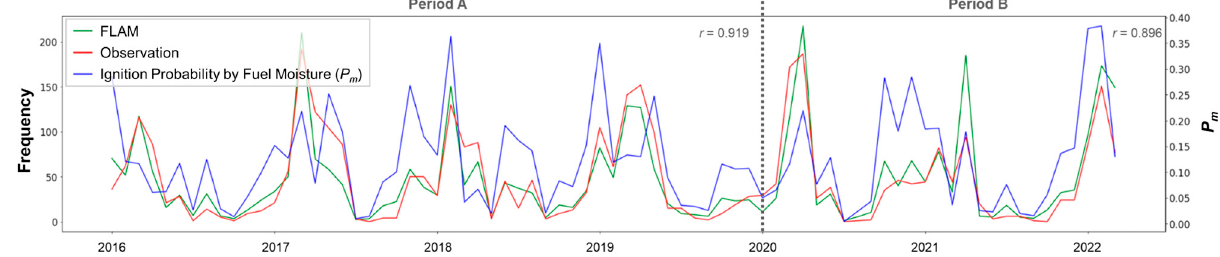
Figure 11. Temporal evaluation of forest fire frequency simulated by the optimized FLAM.